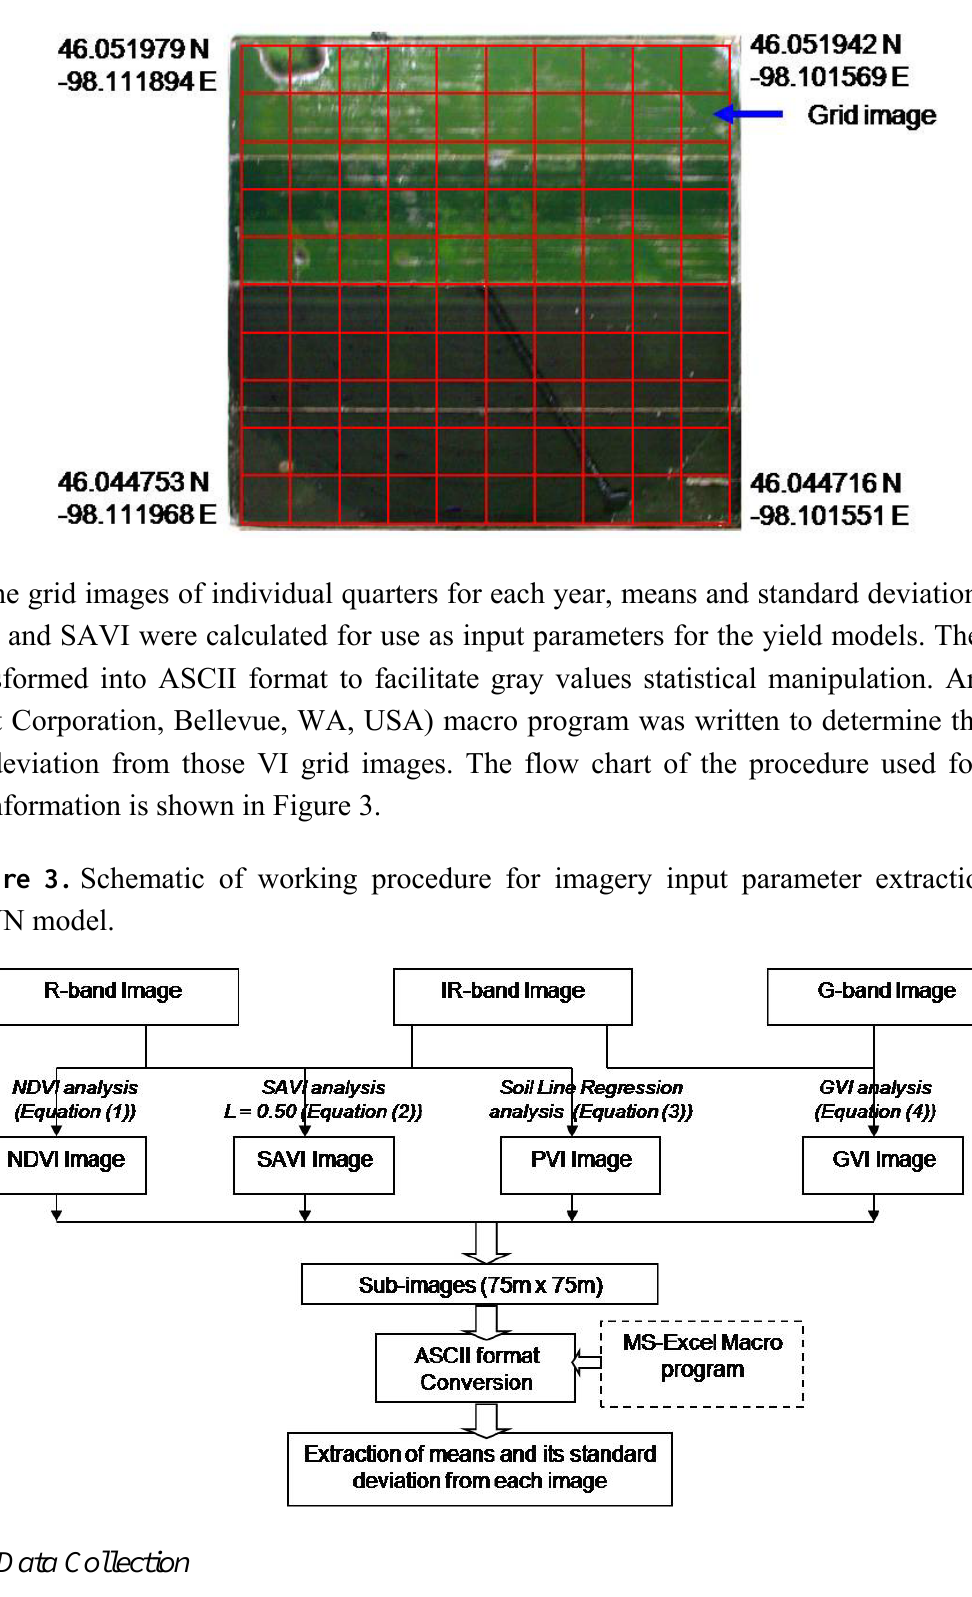
Figure 2. Aerial image of the OITA NW29 quarter in July 30, 1998, showing grid image pattern.